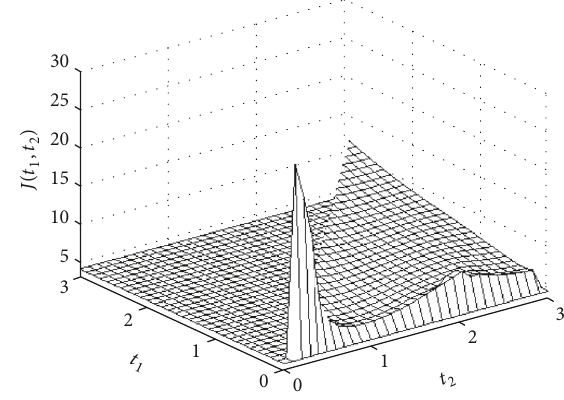
Figure 3: Cost J for different (𝑡 1 ,𝑡 2 ) .